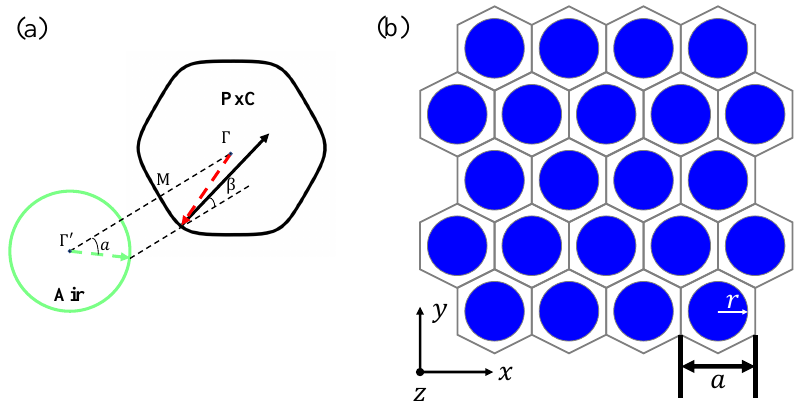
Figure 1. ( a ) Schematic diagram of negative refraction for both EM and acoustic waves in PxC, where green and black lines are EFCs for the same frequency in the air and PxC, respectively. The green arrow represents direction of incident waves and the black arrow denotes the direction of waves in the PxC. The red arrow is wave vector in the PxC. ( b ) Triangular lattice PxC with r being the radius of the Si rod and a being the lattice